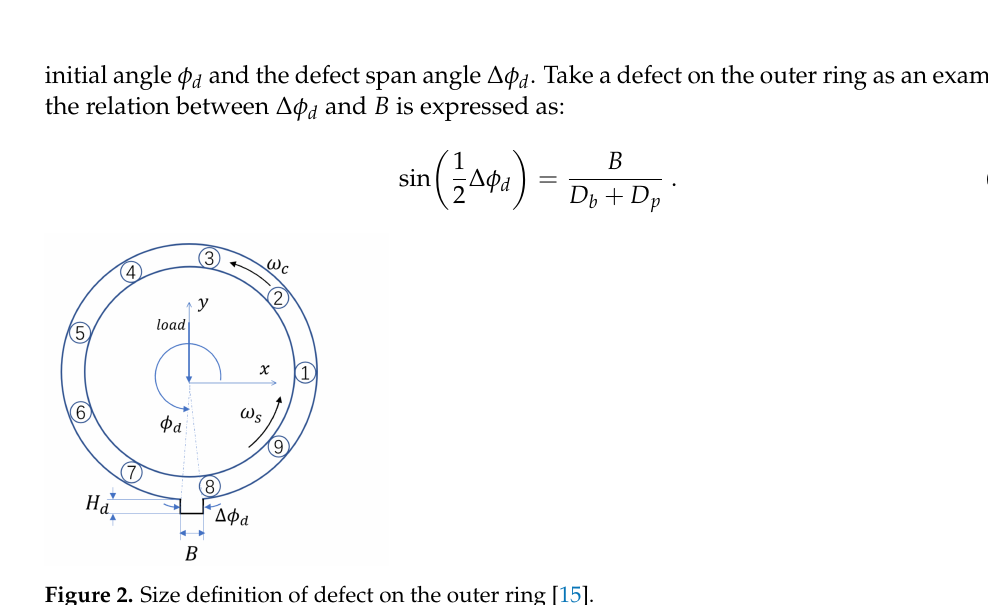
Figure 2. Size definition of defect on the outer ring